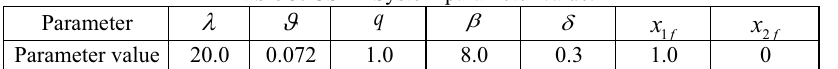
Table 3. CSTR System parameter value.